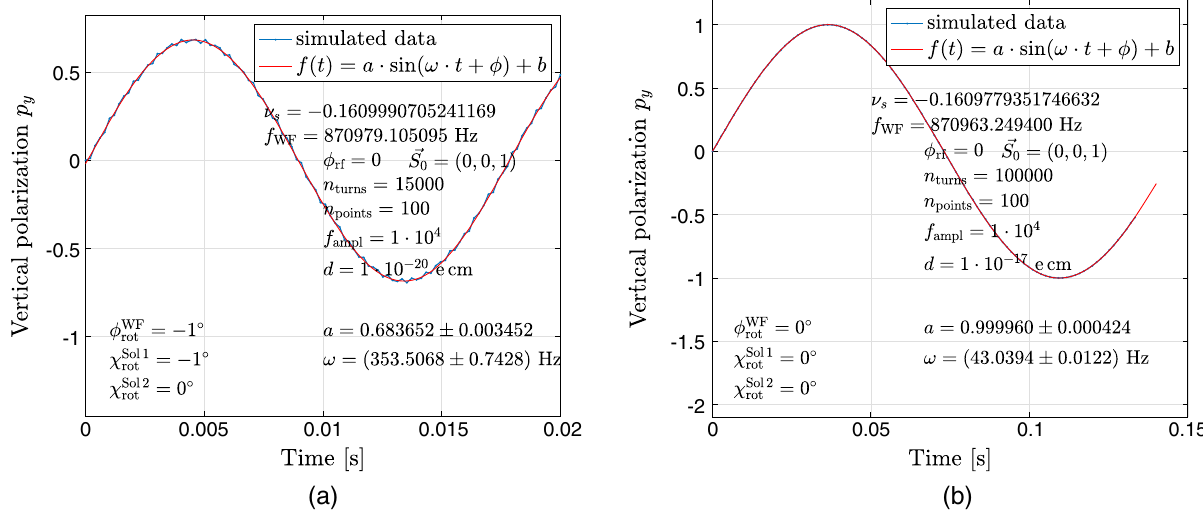
ð t Þ using ⃗ S ð t Þ from Eq. (100) for different combinations of Wien filter and solenoid 3 y Þ , where χ Sol 2 ¼ 0 . The parameters used for the calculation are indicated in each panel. For ; χ Sol 1 rot rot rot